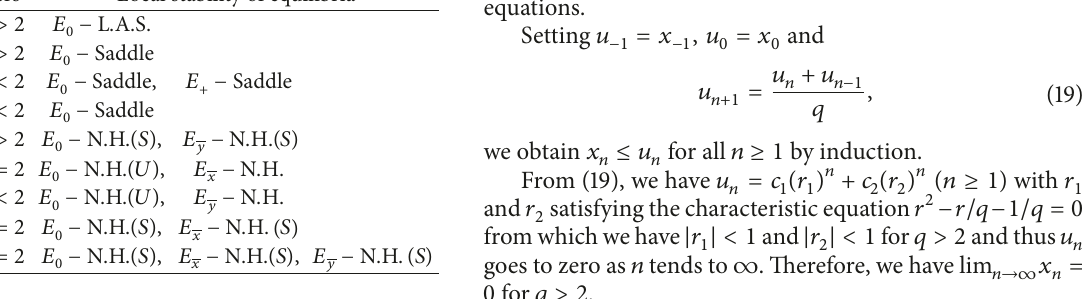
Table 1: Local stability of equilibria of (1). Region